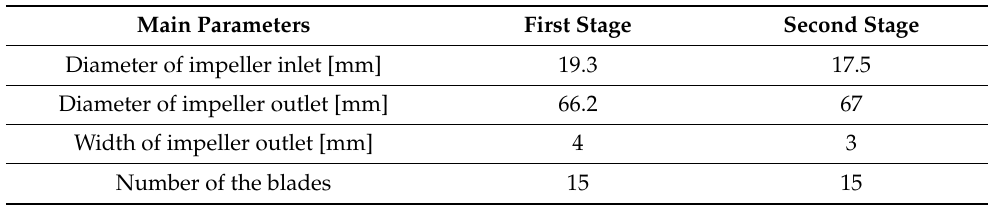
Table 2. Main parameters of the compressor.